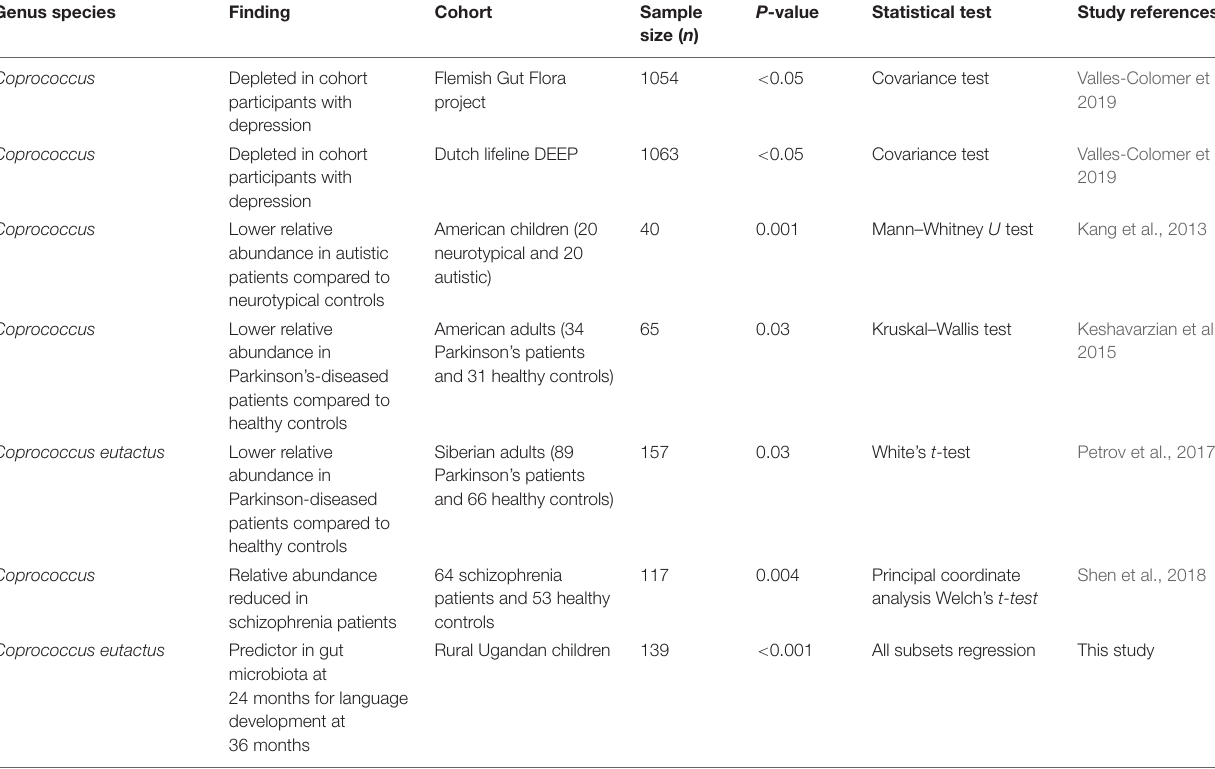
TABLE 3 | Correlations between Coprococcus eutactus and human mental health outcomes. Genus